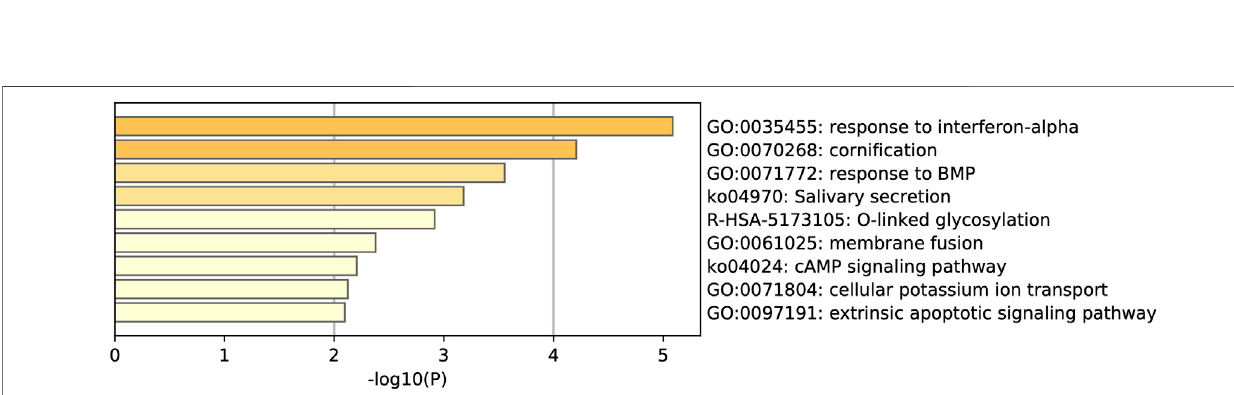
FIGURE 12 | Pathway enrichment for the 58 genes that are common in COVID-19 patients between nasopharyngeal swabs and whole blood samples.